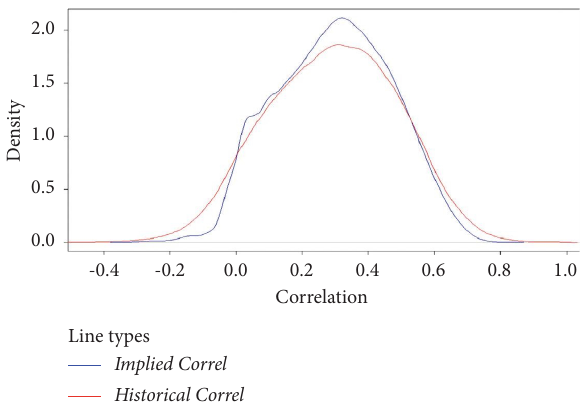
Figure 3: Correlation